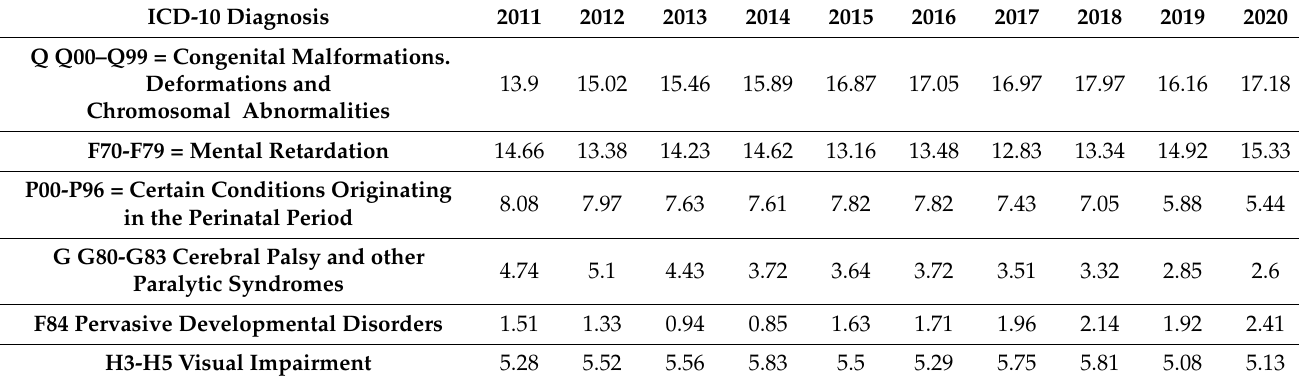
Table 5. Other diagnostic codes present in the studied population and that are associated with hearing loss (percentage).